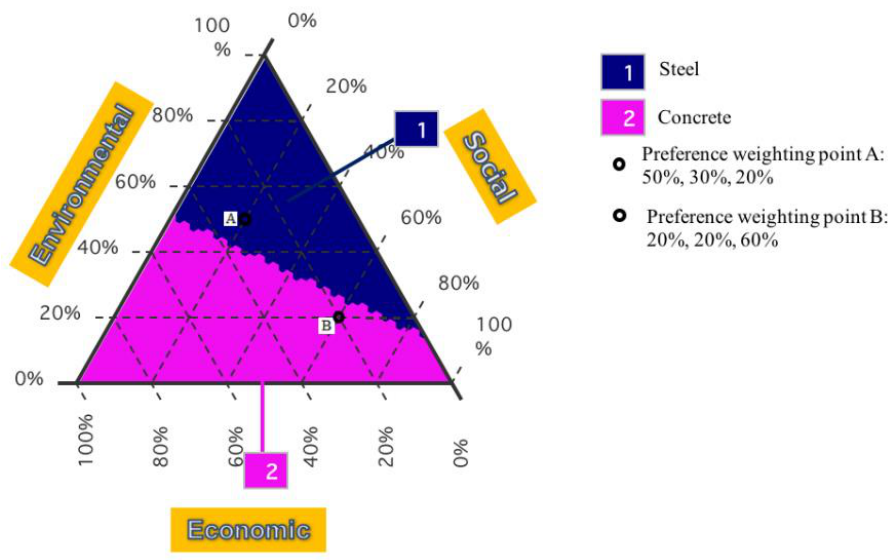
Figure 9. Dominance area of the two frames in mixing triangle.